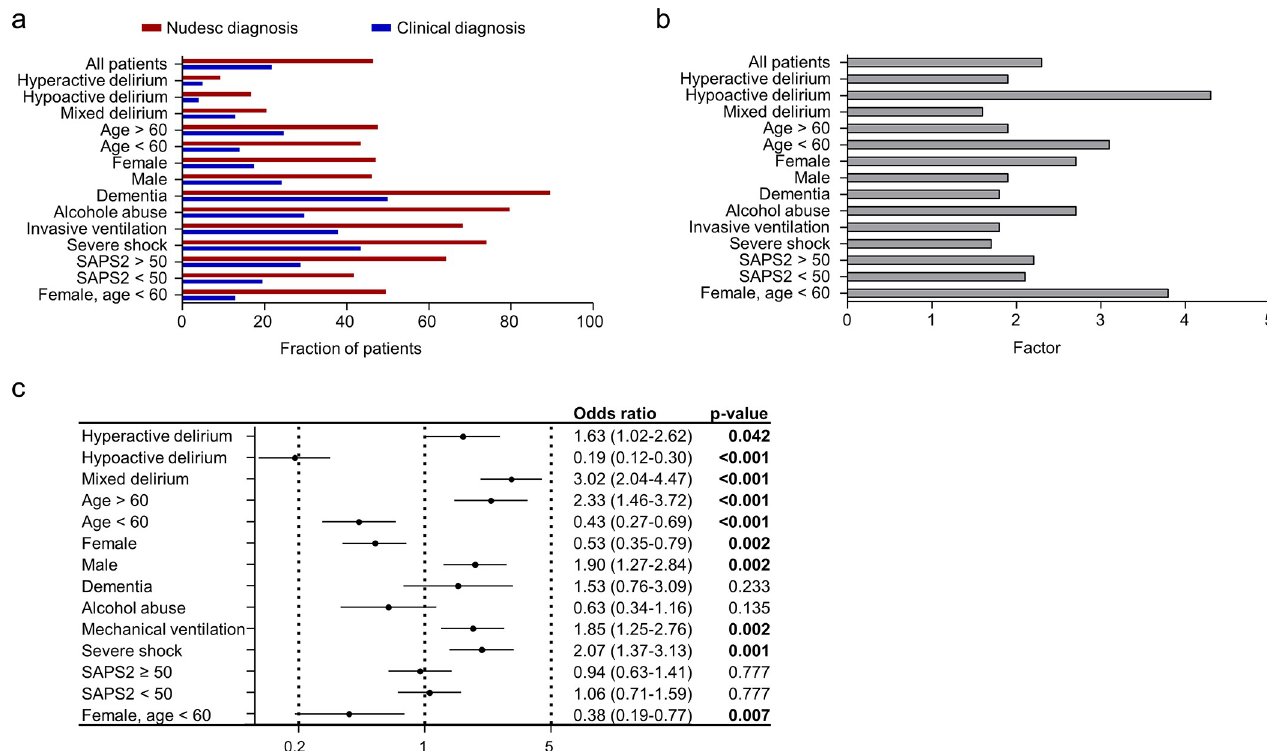
Fig 5. Fraction of delirium positive patients in different subgroups. (a). Factor of fraction of patients with delirium diagnosed by Nudesc divided by patients with clinical diagnosis of delirium (b). Univariate analysis in all Nudesc positive patients predicting a positive clinical diagnosis of delirium (c). Positive Odds ratios represent higher possibilities of a positive clinical